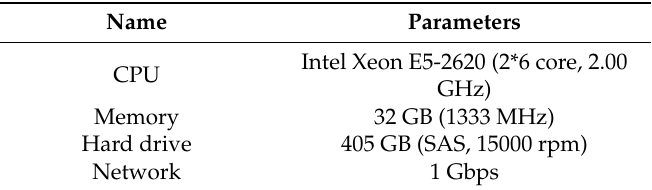
Table 2. Server parameters.